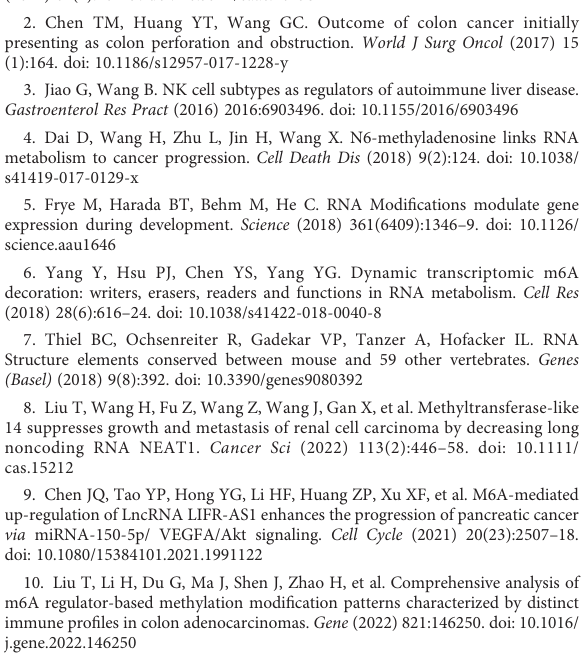
SUPPLEMENTARY FIGURE 2 The expression and prognosis of UBA6-AS1 in COAD. (A) The differential expression of UBA6-AS1 in COAD cancer and paracancer samples. (B) KM survival curve of UBA6-AS1. (C) ROC curve for UBA6-AS1. (D) Relationship between UBA6-AS1 expression with age, (E) N stage, and (F) pathologic